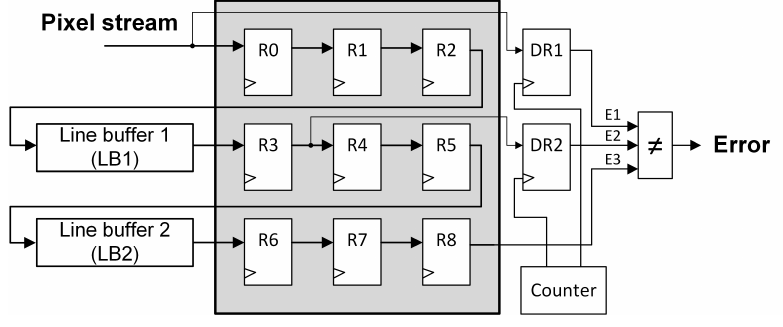
Figure 5. Protected series pipeline.